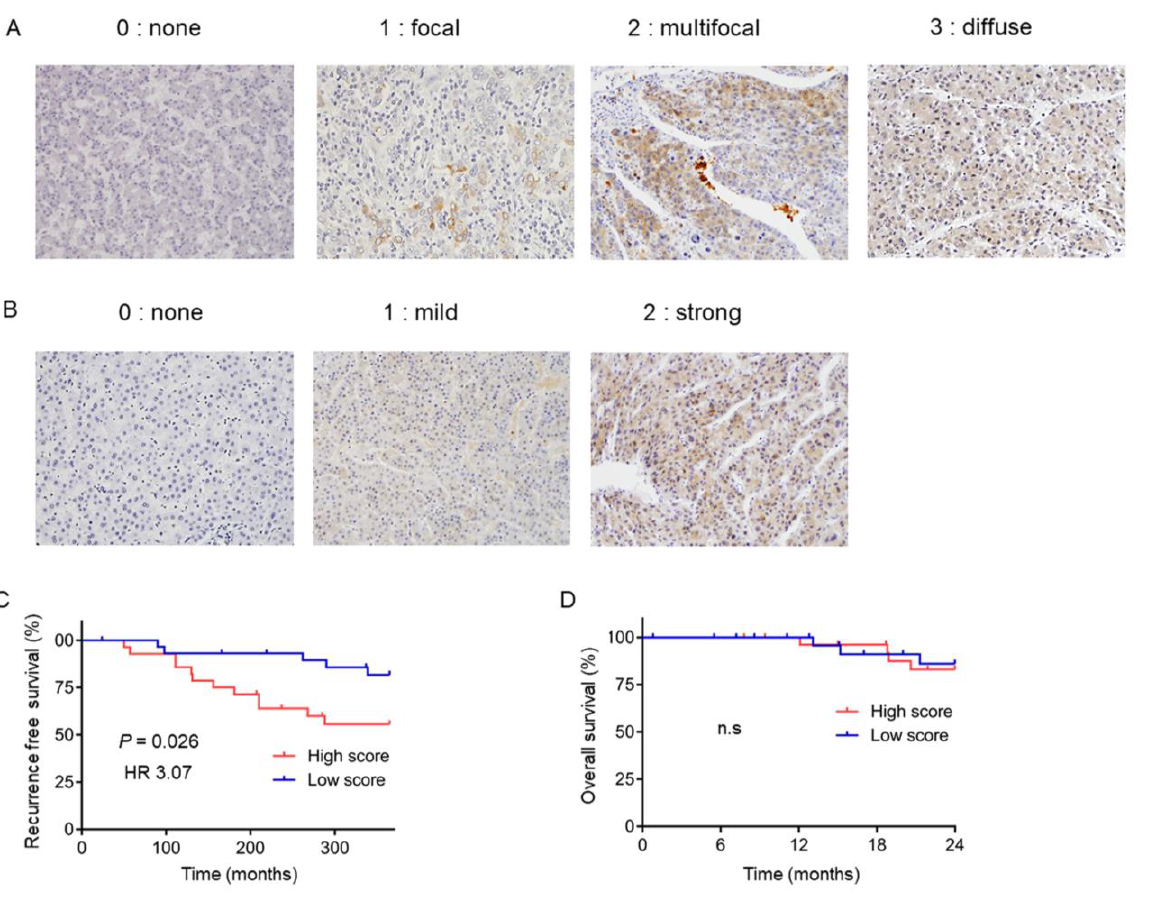
Figure 5. Dickkopf-1 (DKK-1) expression in resected hepatocellular carcinoma (HCC) tissues. ( A , B ) The staining area was evaluated and scored on four levels (none = 0, focal = 1, multifocal = 2, and